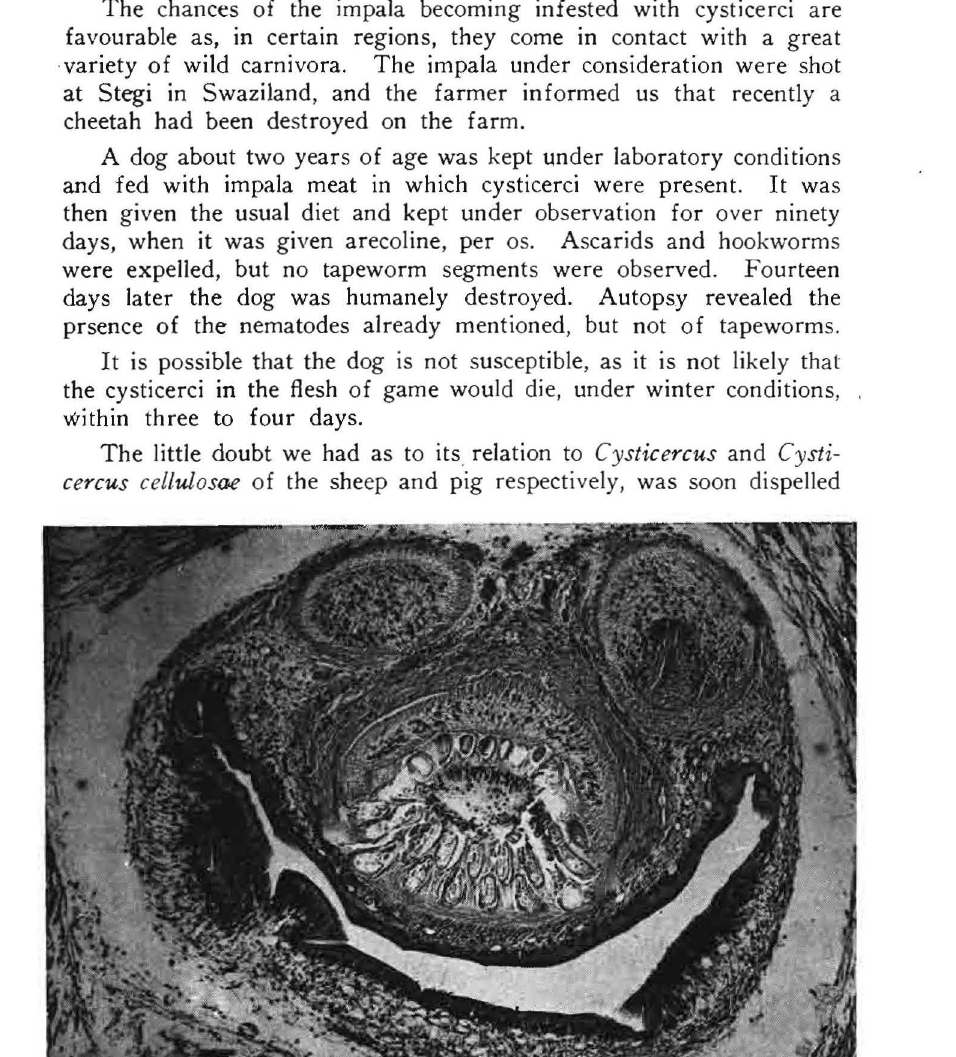
Fig. III. - Photom.icrograph of the cysticercu.s of the impala in section. Stained H aematoxylin-Eosin. (X